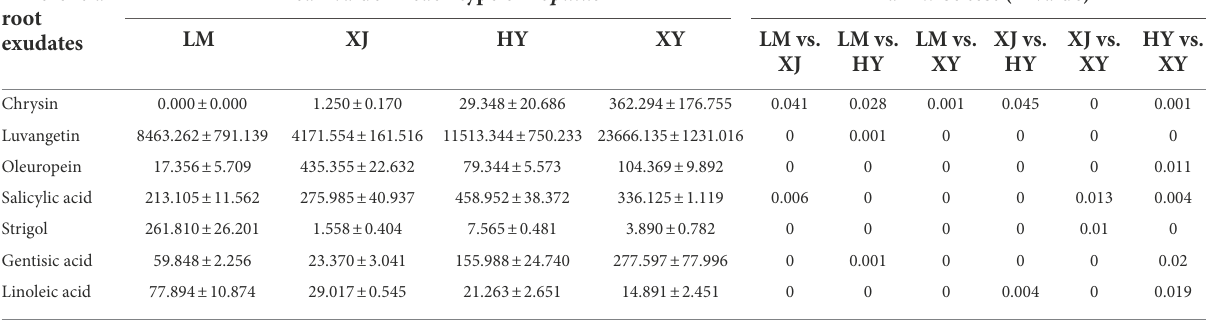
TABLE 2 The peak area of differential root exudates in the rhizosphere of four Populus species.